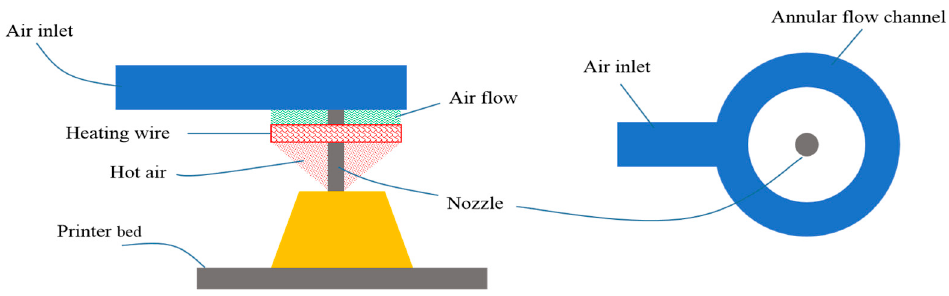
Figure 7. Schematic of in situ hot air flow drying.